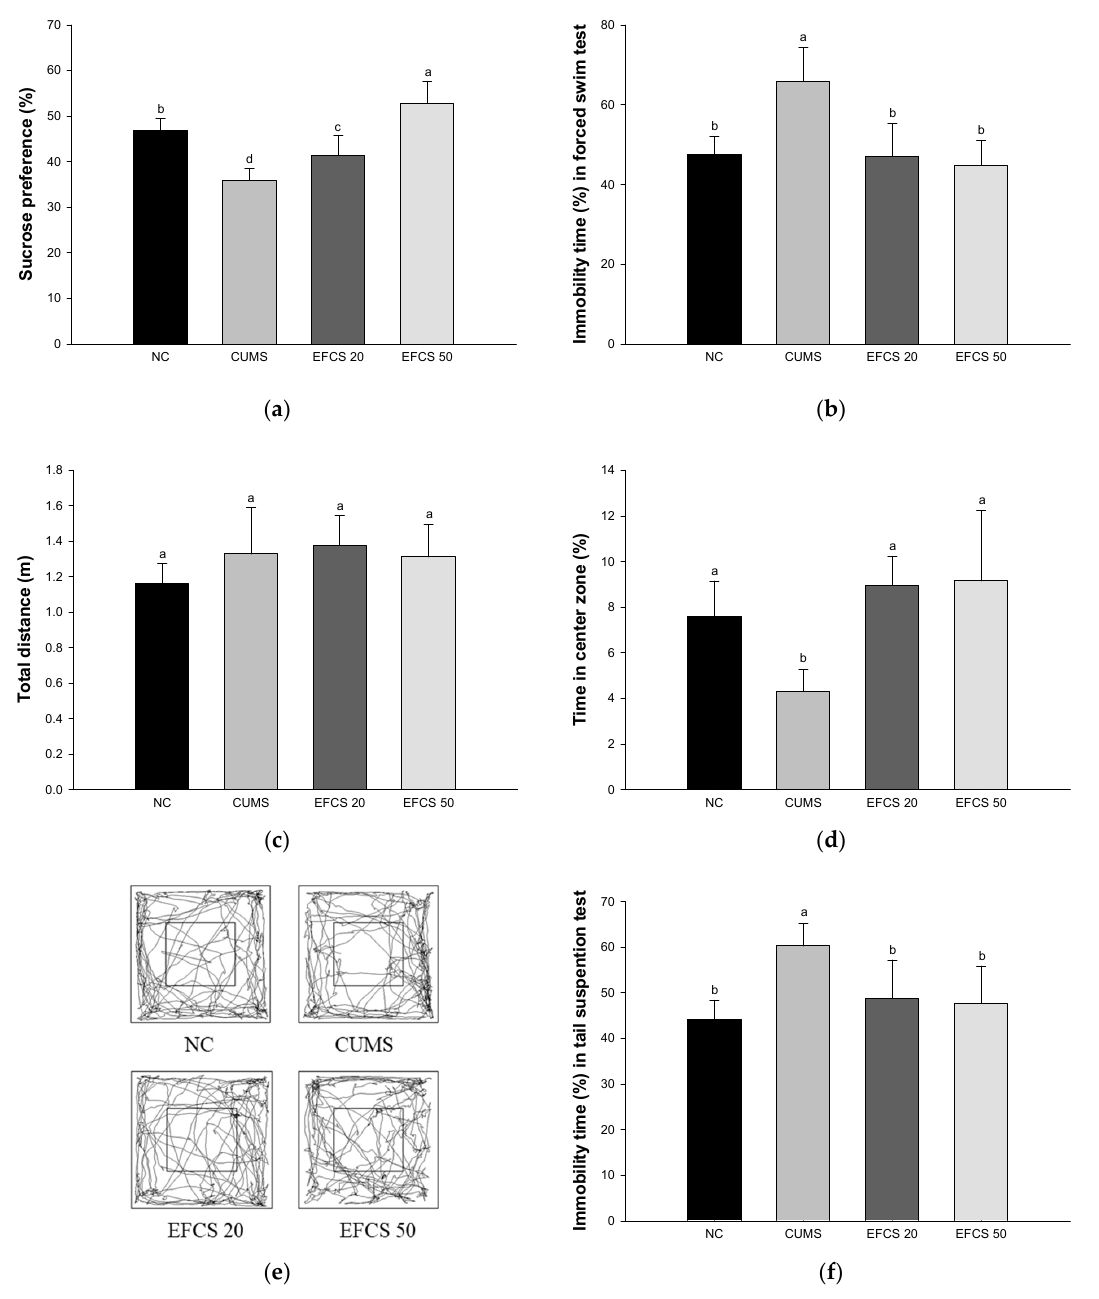
Figure 4. Effects of ethyl acetate fraction from Cedrela sinensis (EFCS) on depression-related behaviors in mice with CUMS exposure. Percentage of sucrose preference in sucrose preference test (SPT) ( a ), percentage of immobility time in forced swimming test (FST) ( b ), the total distance in open field test (OFT) ( c ), percentage of center zone in OFT ( d ), path tracing on the probe trial ( e ) in OFT and percentage of immobility time in tail suspension test (TST) ( f ). Results shown are mean ± SD ( n = 5). Data are statistically represented at p < 0.05, and different lowercase letters indicate statistical significance. Means with the same letter are not significantly different.